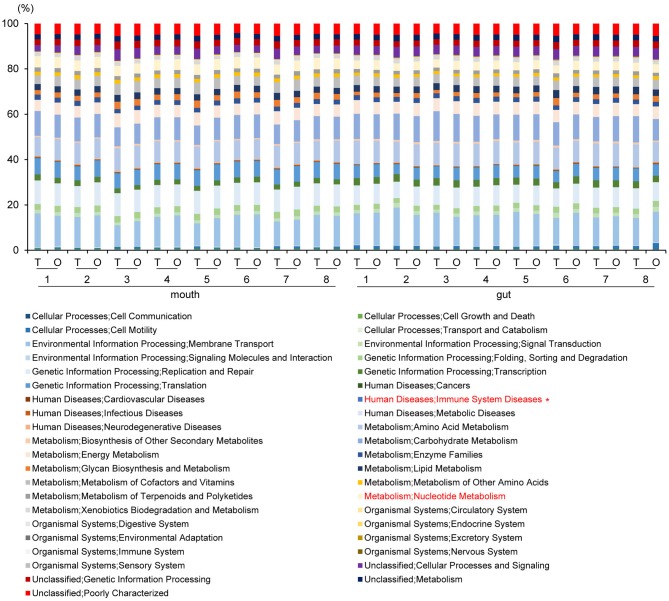
Metagenome prediction at second-level categories among oral and gut microbiome between tube and oral feeding (n = 8). *Adjusted P < 0.05 between tube and oral feeding (paired t-test with FDR). T, tube feeding; O, oral feeding.